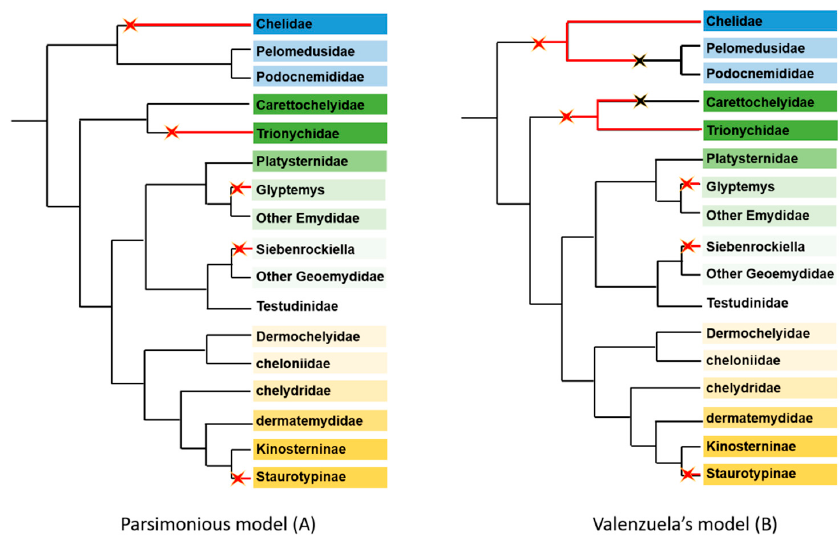
Figure 8. Models for transitions among sex-determining mechanisms in turtles. Black lines indicate branches where TSD occurs, red lines indicate branches where GSD occurs. Red stars indicate TSD to GSD transitions, black stars indicate GSD to TSD transitions. ( A ) Parsimonious model with five independent TSD to GSD transitions; ( B ) Valenzuela’s model with two older TSD to GSD transitions in pleurodira and trionychia, respectively, and two putative GSD to TSD transitions in pelomedusoides and carettochelyidae, respectively.